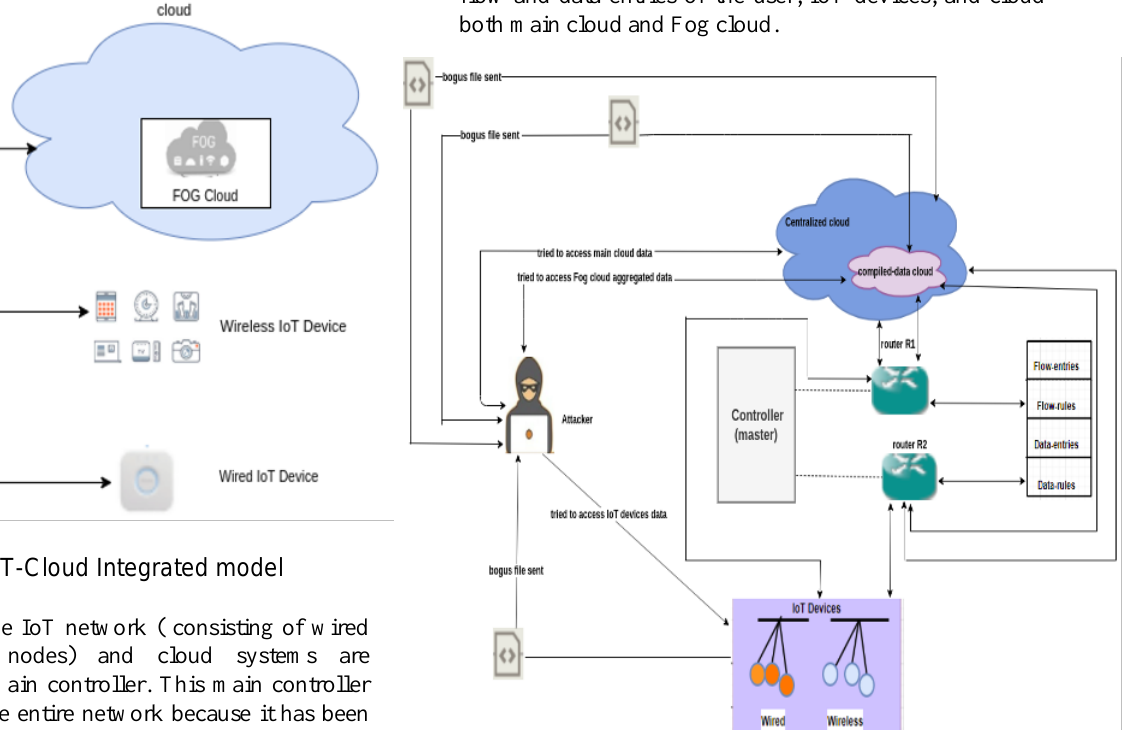
Figure 4. IoT-Cloud Secure